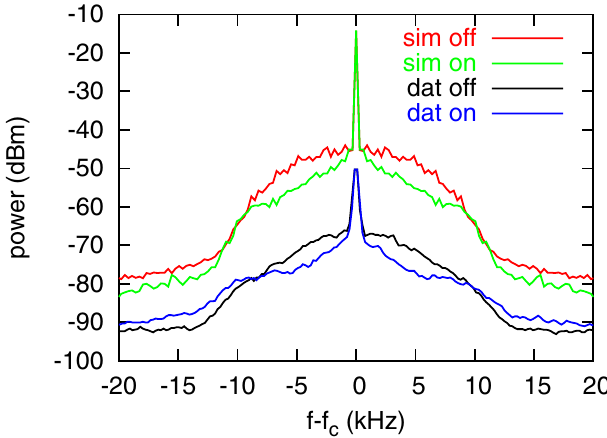
FIG. 7. (Color) Comparison of simulated and actual signal sup- pression. The red and green lines are the simulated Schottky spectra with cooling off and on, respectively. The black and blue lines are the measured data with the cooling system off and on, respectively. The simulations are offset by (cid:5) 20 dB for